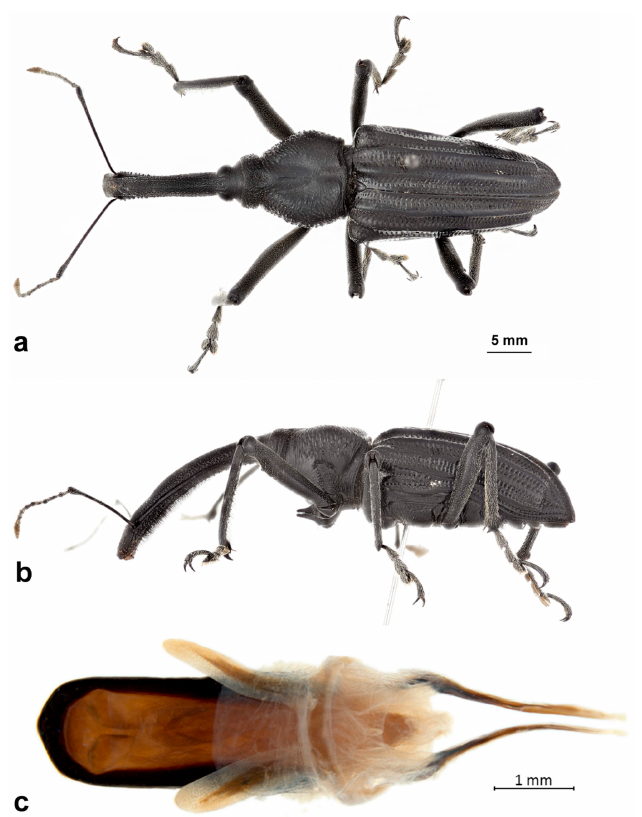
Figure 1. Vanapa oberthuri : ( a ) habitus of male, dorsal aspect; ( b ) habitus of male, lateral aspect; ( c ) aedeagus, dorsal aspect.